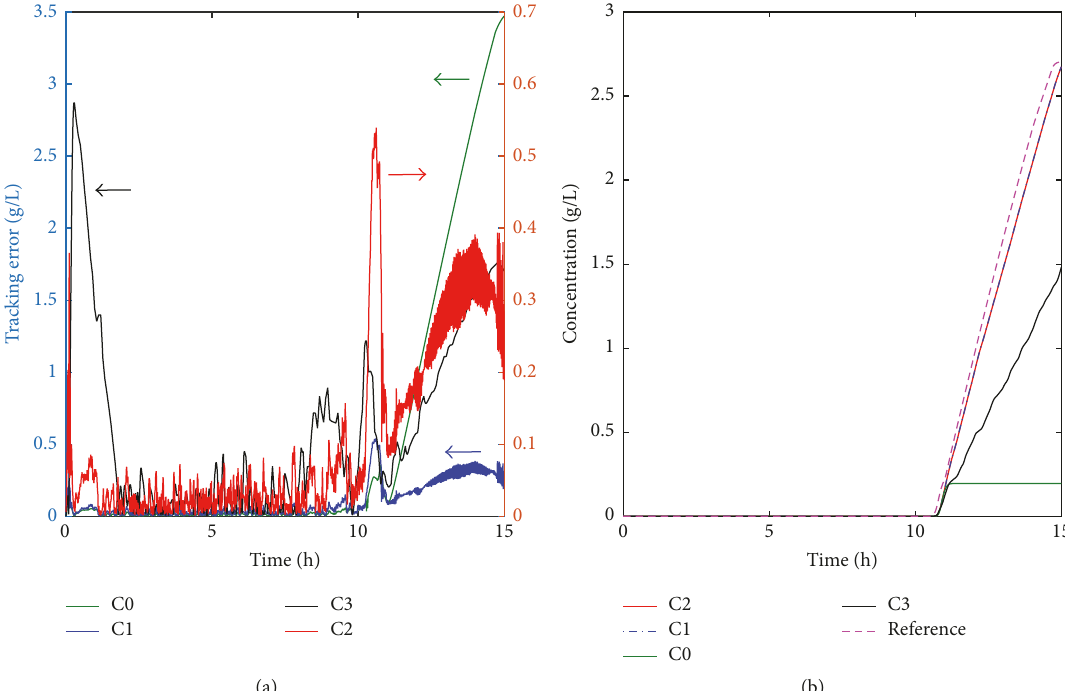
Figure 5: (a) Comparison of the tracking errors (see (31)) (right ordinate axis: C2; left axis: C0, C1, and C3). (b) Total protein concentration